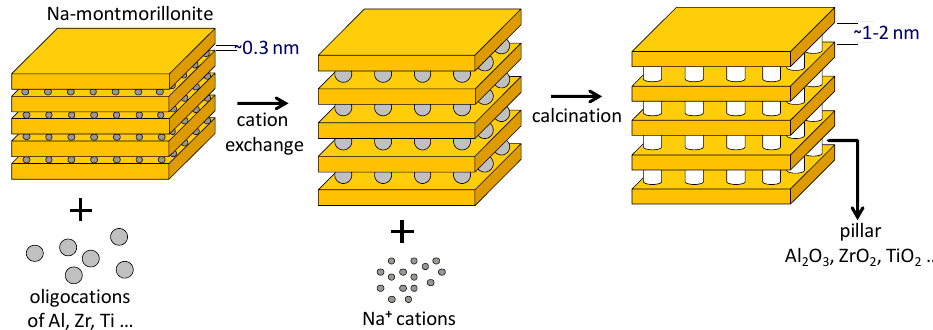
Figure 4. Schematic illustration of clay pillaring process.